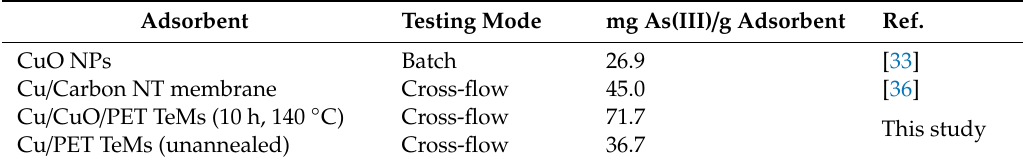
Table 4. As(III) adsorption capacities of various nanosized adsorbents.